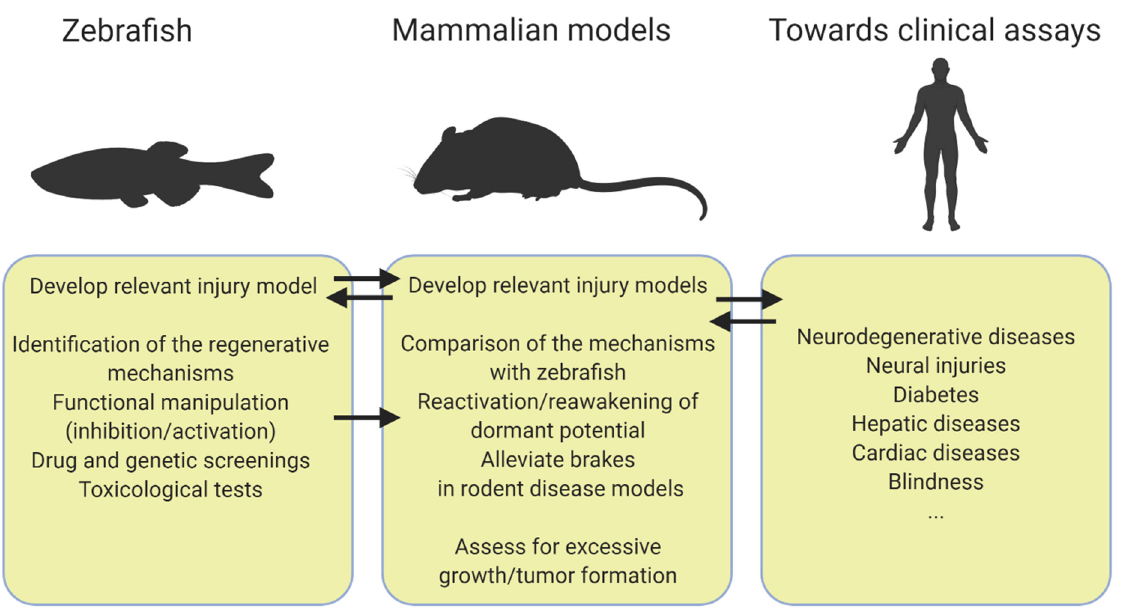
Figure 1. Workflow from zebrafish to mammals. Created with Biorender.com.